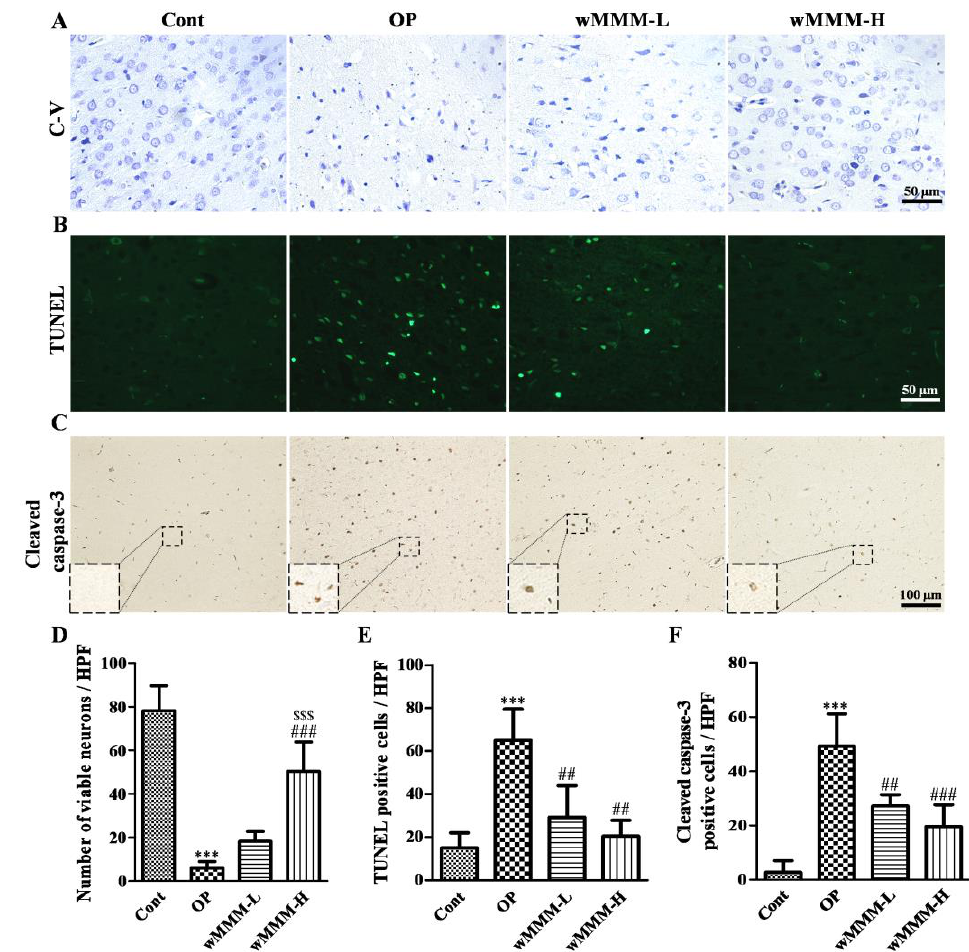
Figure 6. Anti-apoptotic effects of water extracts of mixed mushroom mycelia (wMMM) on an in vivo focal cerebral ischemia (fCI) model. Representative C-V stained ( A ), TUNEL-stained ( B ), and Cleaved caspase-3-immunostained ( C ) images of an fCI cortical lesion and the corresponding quantitative bar graphs ( D – F ). For viable neuronal counts shown in ( D ), only neurons with an intact cytoplasm and visible nucleolus were considered “viable”. In ( C ), the cleaved caspase-3-immunoreactive cells have been magnified and presented in rectangular inlets as indicated. In all bar graphs, data are presented as the mean ± standard deviation (*** p < 0.001 vs. Cont; ## p < 0.01 and ### p < 0.001